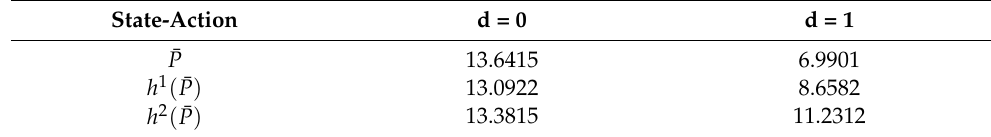
Table 4. Convergent Q -table based on SARSA from the perspective of attacker.